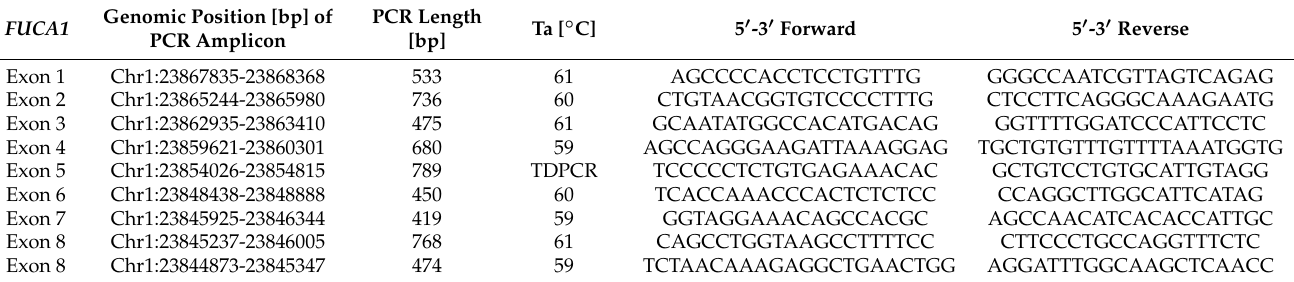
Table 1. PCR amplification